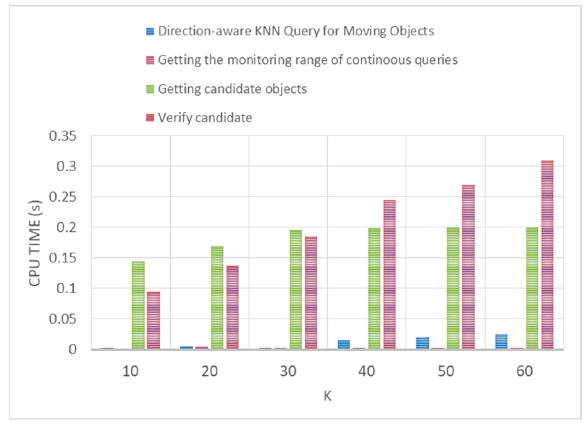
Figure 14. Time-consuming for each stage of continuous query for different K values. Figure 12. Time-consuming for each stage of continuous query for di ff erent K values. Figure 11. Effect of K value on Performance.